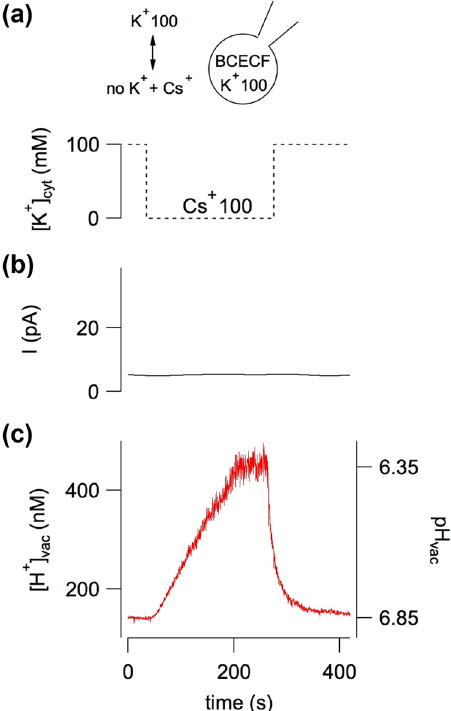
Figure 1: A cytosol - directed potassium gradient induced vacuolar acidi fi cation. ( a ) Schematic representation of cytosolic potassium removal ( 100 mM K + ) and substitution with an equimolar amount of cesium ( no K + + Cs + ) versus time. The dotted lines indicate the switching of the bath solution irrespective to the real change rate due to the perfusion system. ( b ) Current, recorded by the patch - clamp technique applied on a vacuole isolated from Arabidopsis mesophyll cells, did not change. ( c ) Luminal concentration of potassium, detected by the proton - sensitive fl uorescent dye BCECF loaded inside the vacuole through a patch pipette, increased sig - ni fi cantly after K + removal. Modi fi cation of Figure 1, from Gradogna et al. [ 57 ] , New Phytologist , 229:3026 – 36, reprinted by